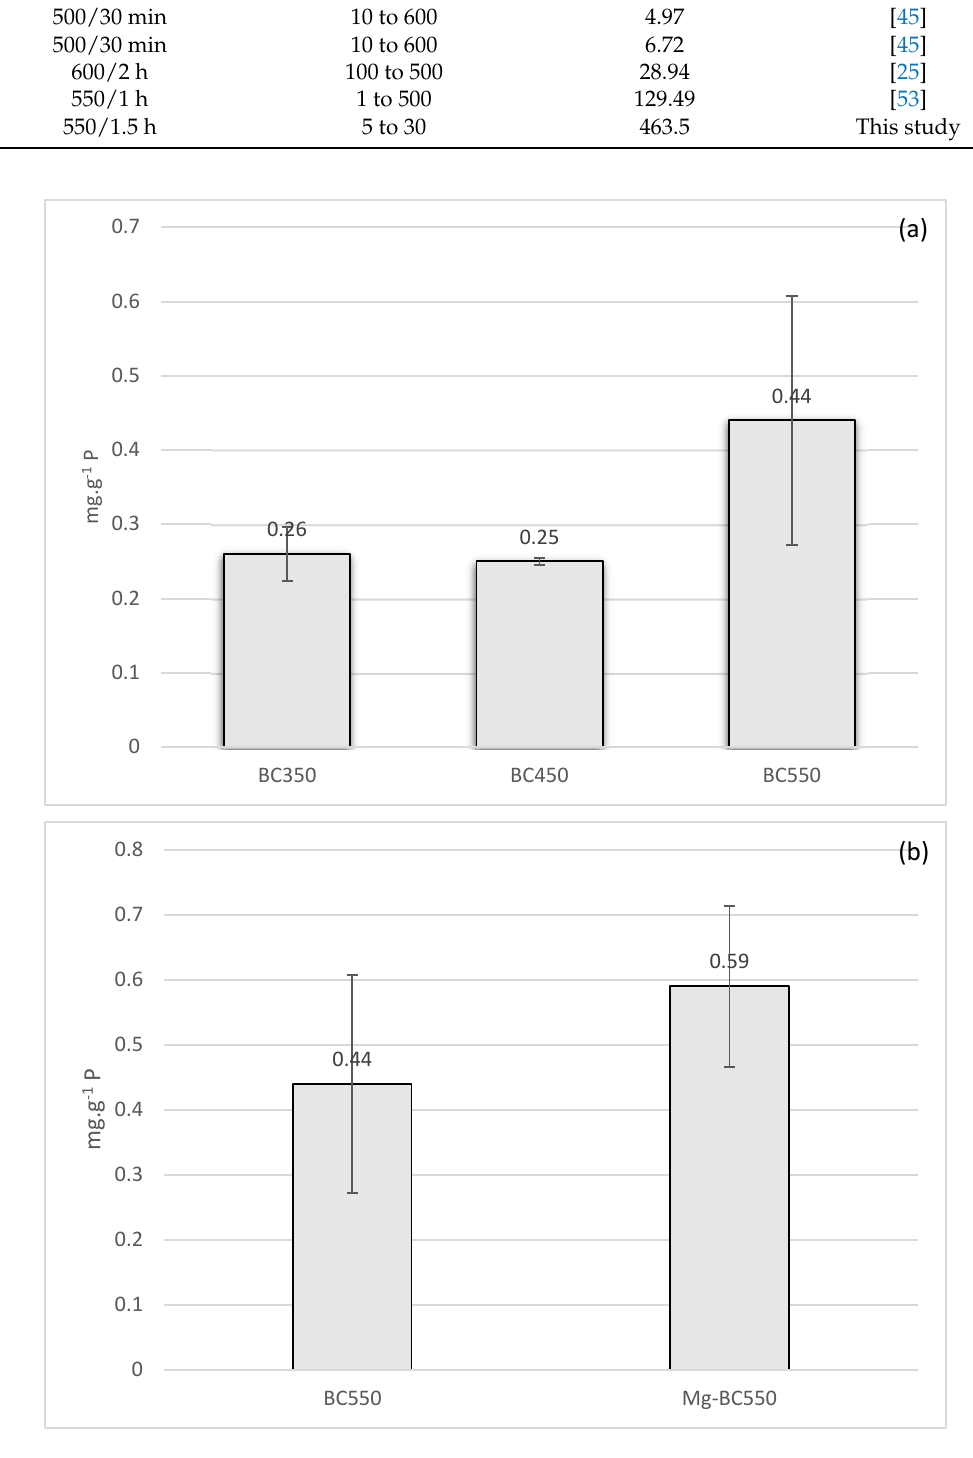
Figure 5. Adsorption of P by: ( a ) unmodified biochar at different pyrolysis temperatures; and ( b ) unmodified and Mg modified biochar at 550 °C (mean ± standard deviation).